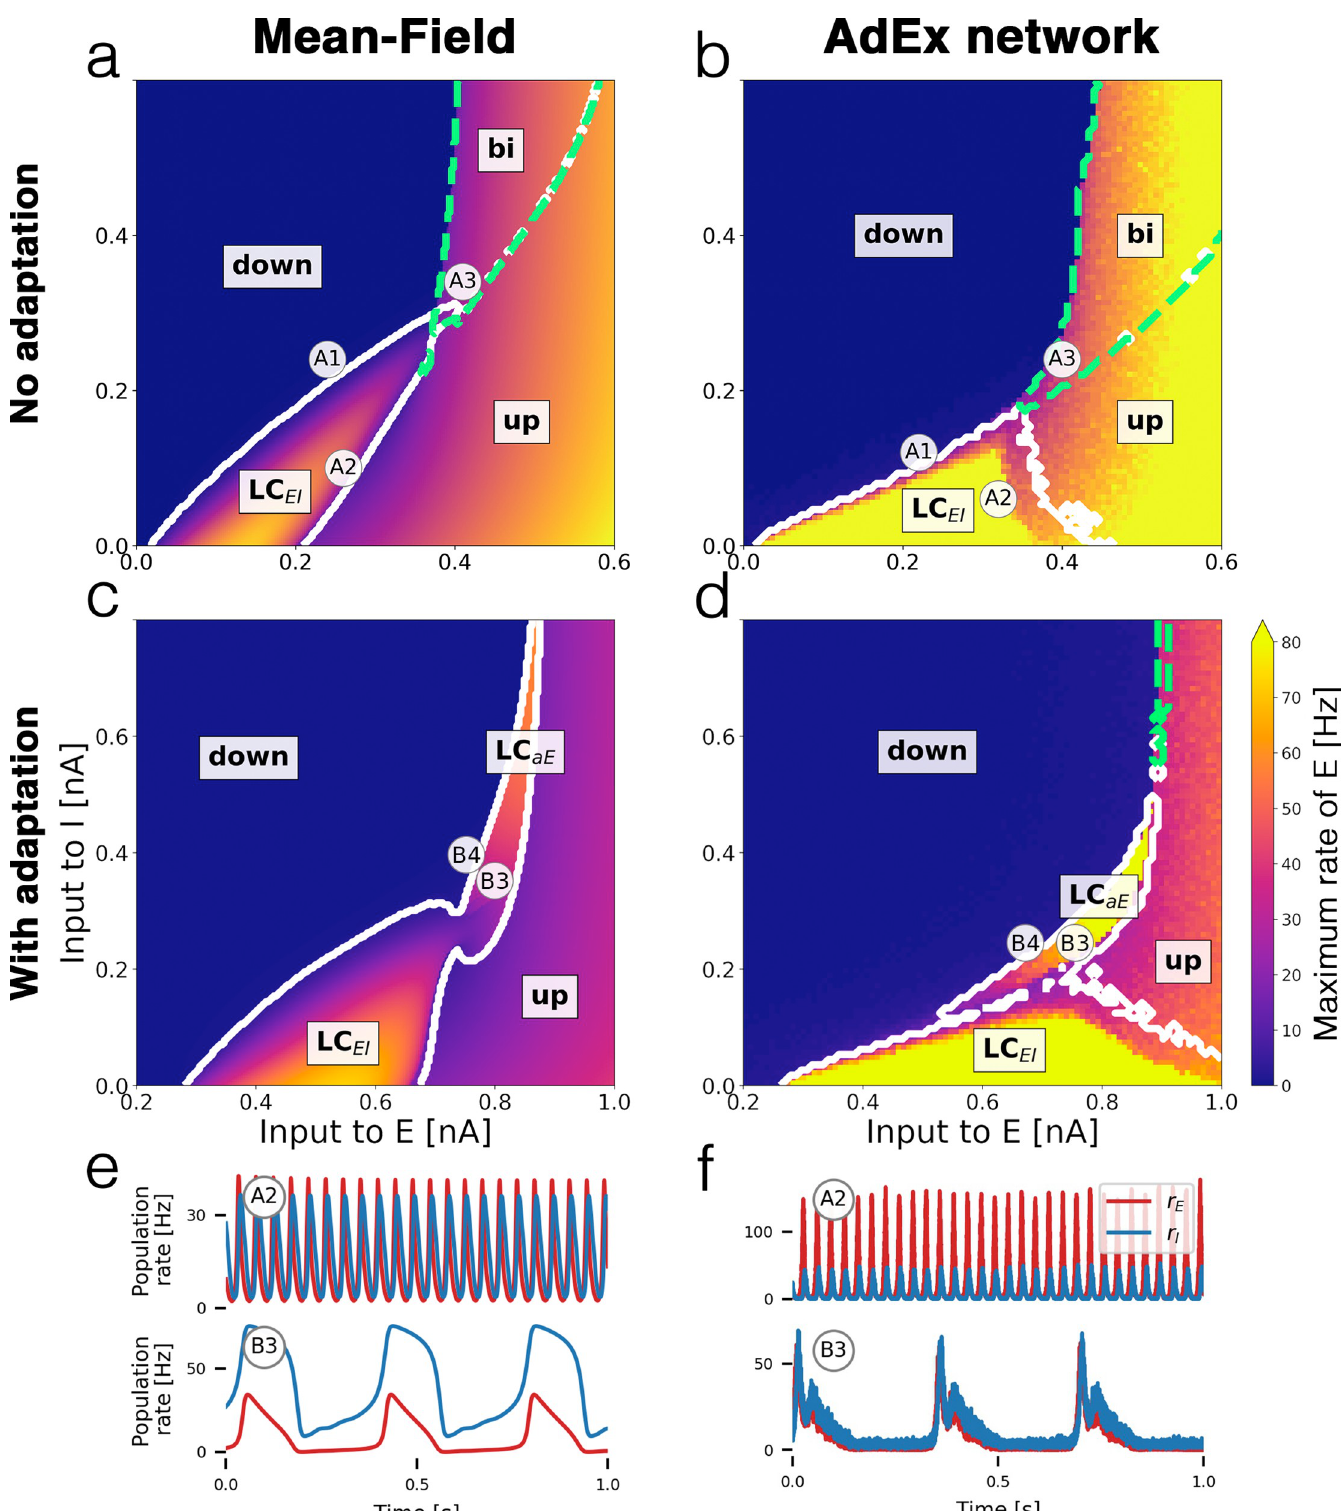
Fig 2. Bifurcation diagrams and time series. Bifurcation diagrams depict the state space of the E-I system in terms of the mean external input currents to both subpopulations α 2 { E , I }. (a) Bifurcation diagram of mean-field model without adaptation with up and down-states , a bistable region bi (green dashed contour) and an